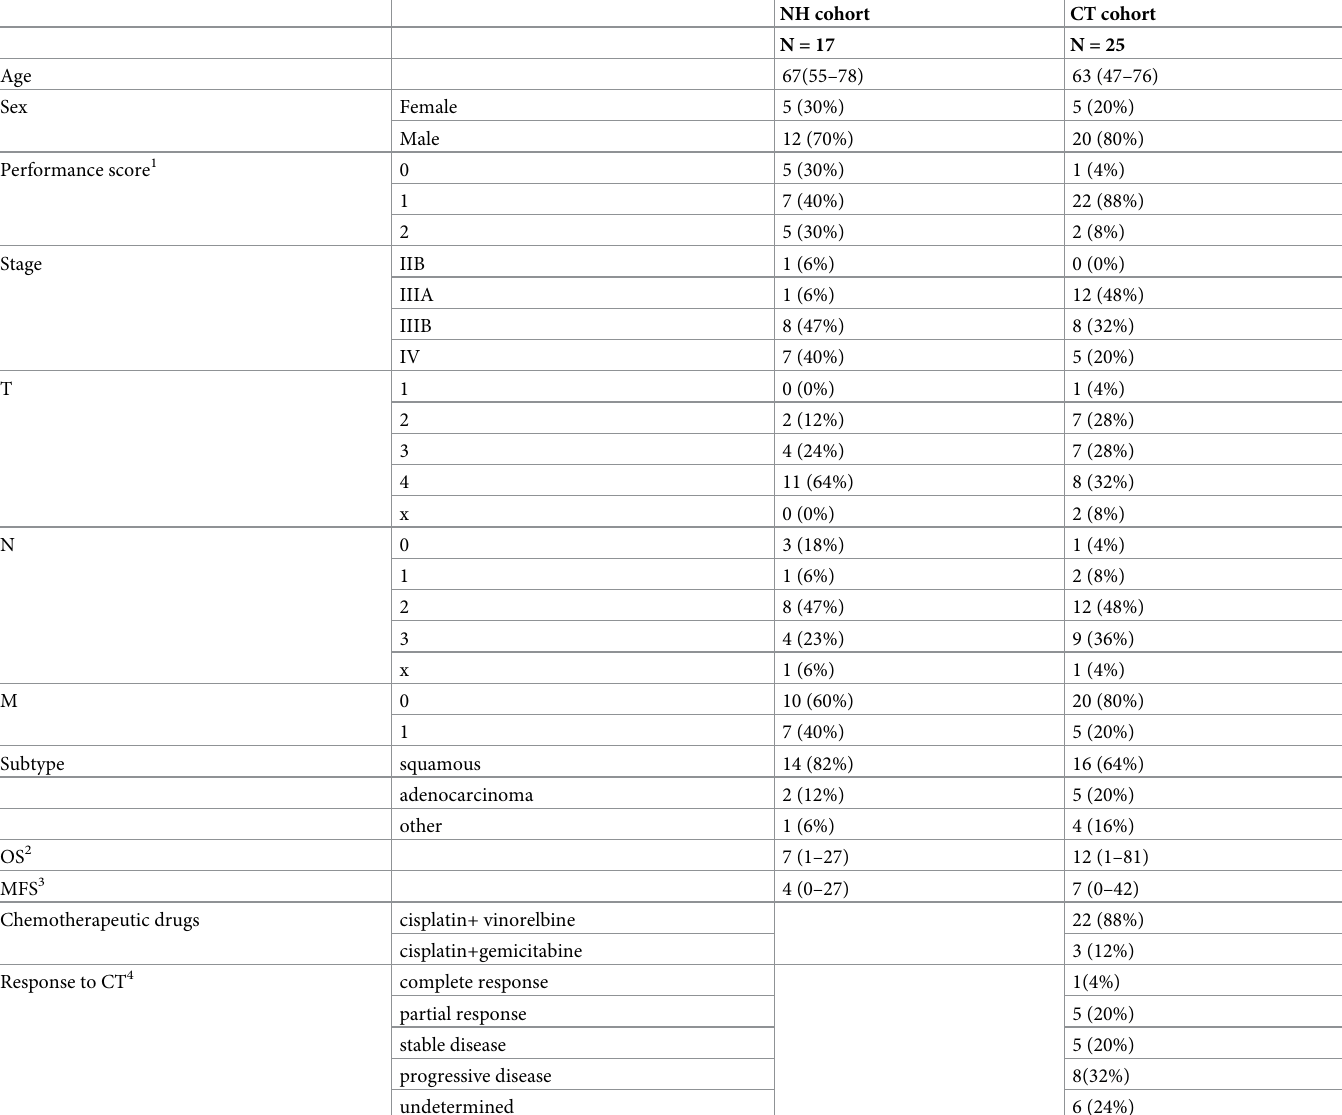
Table 2. Summary of patient cohort. Comparison of natural history (NH) cohort with chemotherapy (CT) cohort. 1 Performance score–performance score using Zubrod scale, 2 OS–overall survival, 3 MFS–metastatic-free survival, 4 response to CT–response to chemotherapy according to RECIST